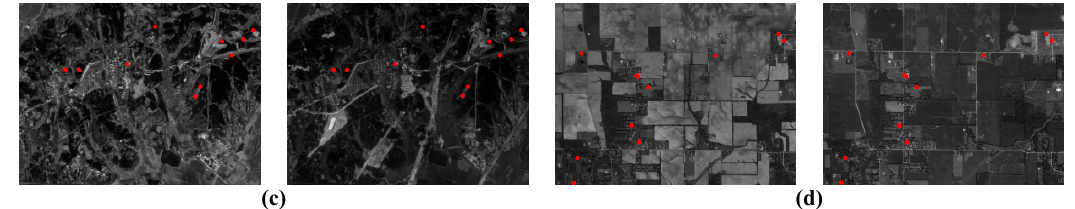
Figure 14. Matching results of SIFT. The matches of Pairs 1, 2, 3, and 5 are shown in ( a ), ( b ), ( c ), and ( d ), respectively. No correct match is obtained for the images of Pairs 4 and 6 (i.e., see Table 2).